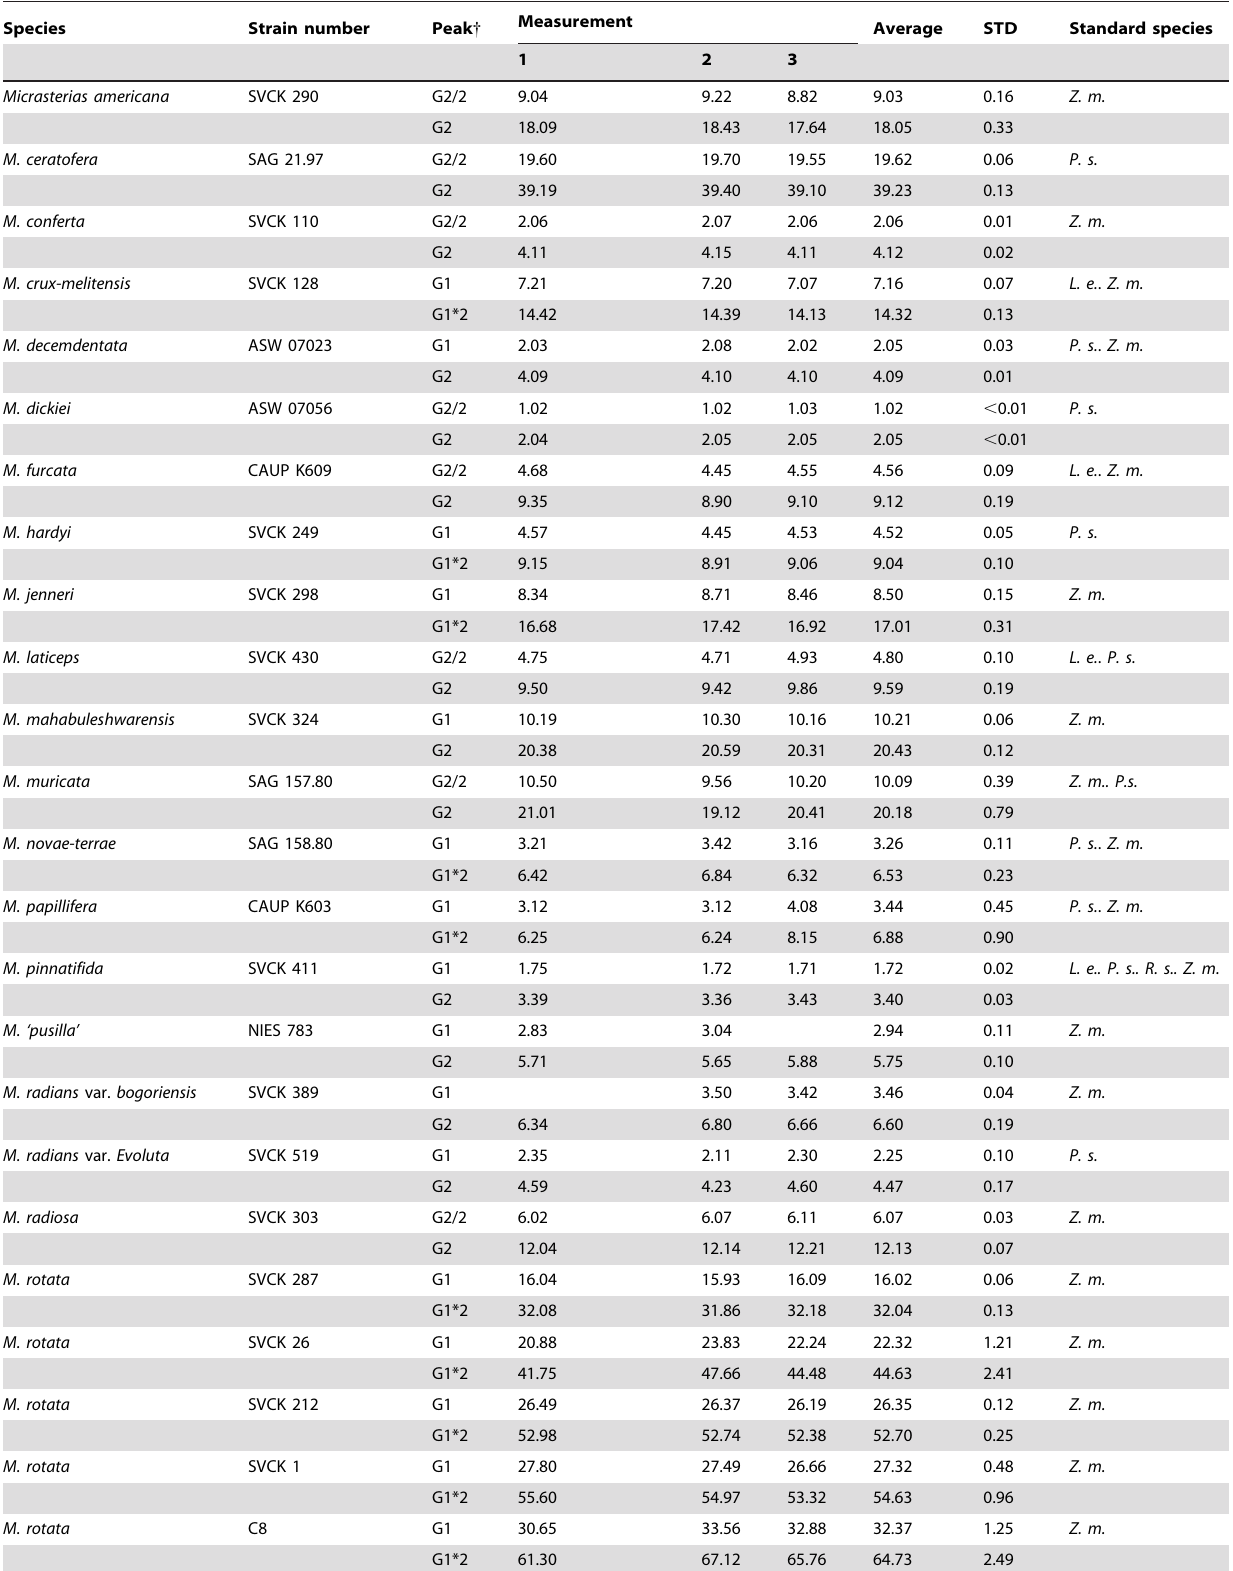
Species Strain number Peak { Measurement Average